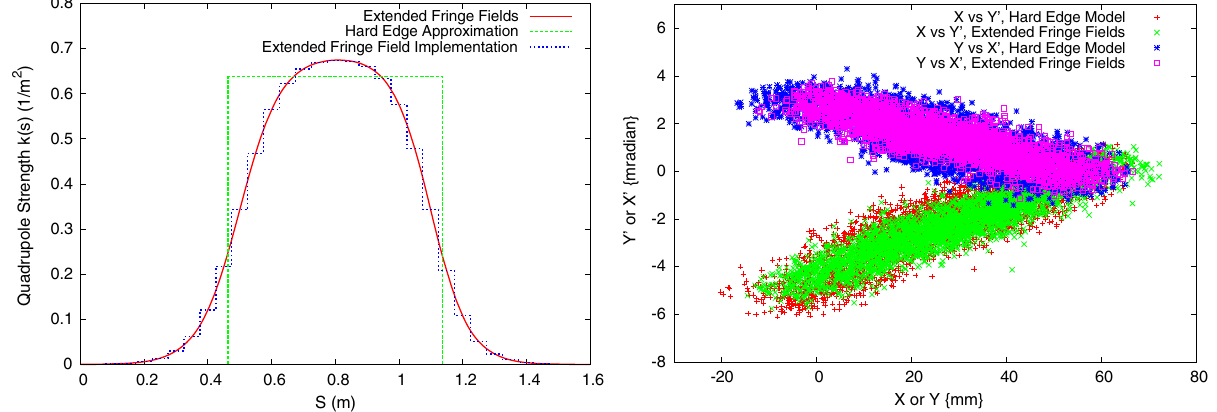
FIG. 5. (Left) Quadrupole strength functions for the hard-edge model (green), for an extended fringe field model (red), and for ORBIT ’ s extended fringe field implementation (blue). The integrated areas under the three curves are equal. (Right) Comparison of beam distributions for a painted self-consistent beam using the hard edge (red and blue) and ORBIT ’ s extended (green and pink) fringe field